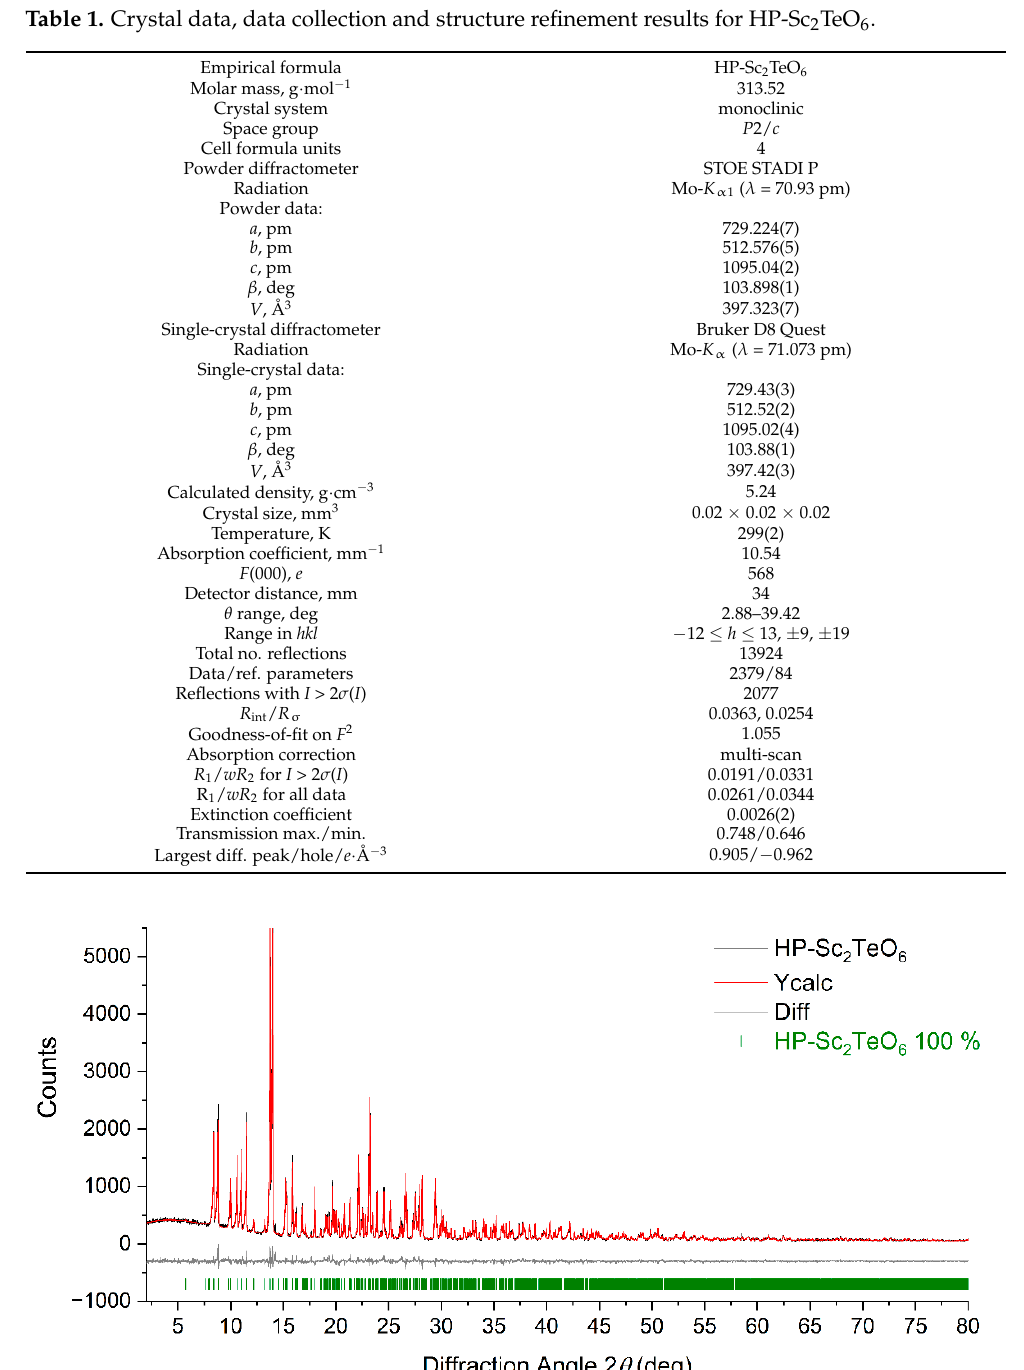
Figure 1. XRPD pattern (Mo- K α 1 radiation) and Rietveld refinement of X-ray pure HP- Sc 2 TeO 6 displayed with an offset of 750 counts ( R exp = 6.98, R wp = 7.56, R p = 5.67 and GooF =